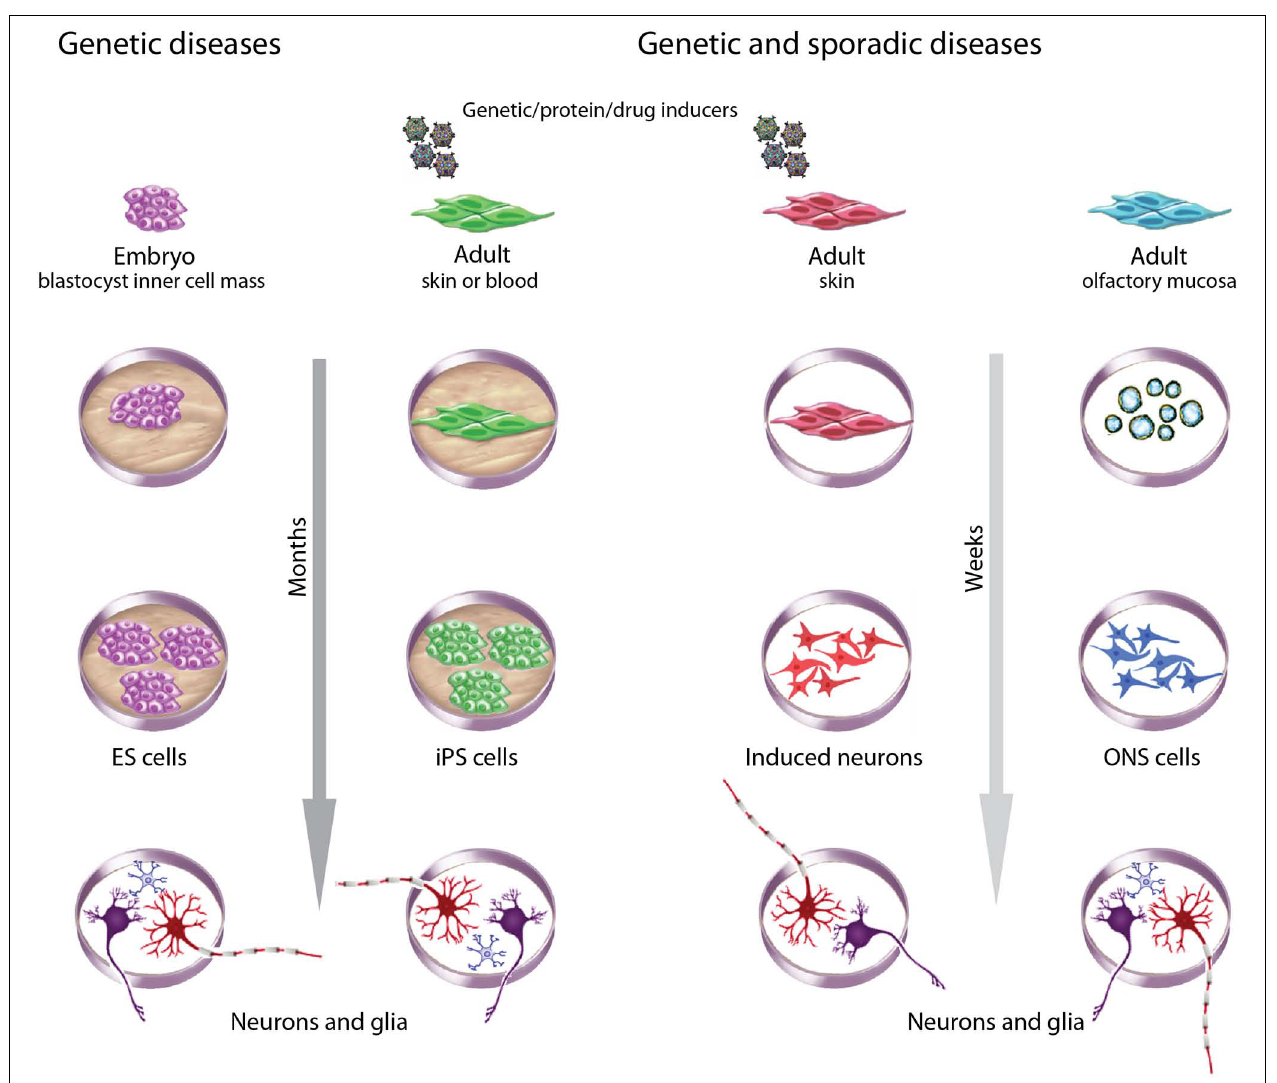
FIGURE 3 | Choices of stem cells to model brain diseases. Different criteria guide choices of cells to model brain diseases. ESCs derived during pre-implantation genetic diagnosis are useful for monogenic diseases. Patient-derived adult cells are useful for genetic and sporadic diseases, with the advantage of an associated clinical history. ESCs and iPSCs take many months to generate, validate, and then to produce neurons and glia but have the advantage of being highly proliferative and pluripotent. iPSCs and induced